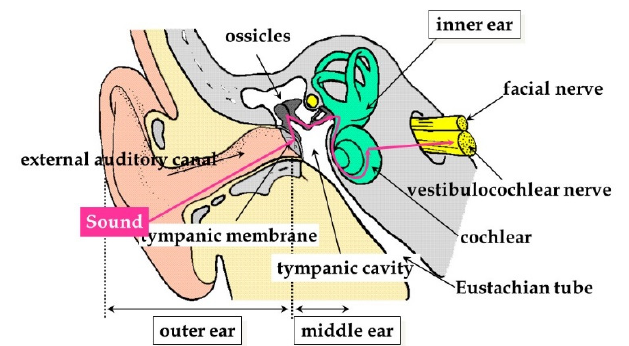
Figure 1. The internal anatomy of the ear.